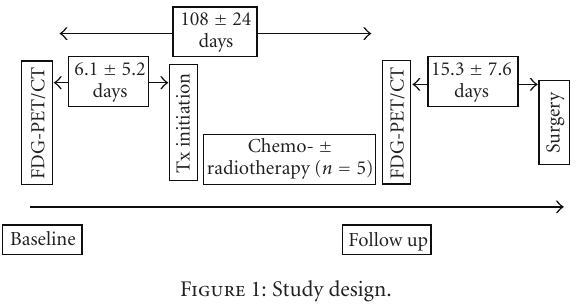
Figure 1: Study design.